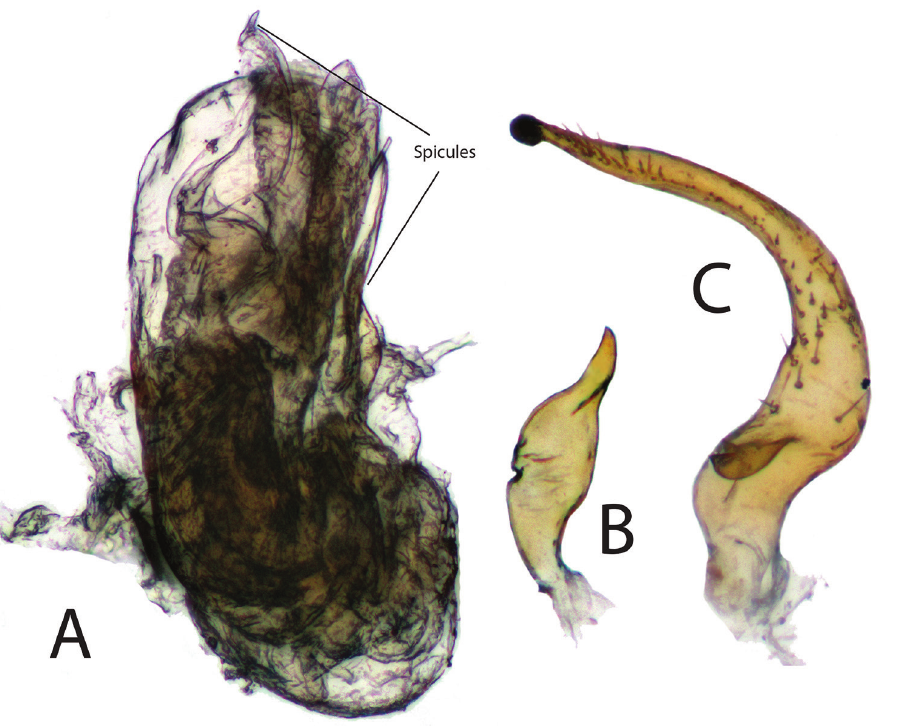
Figure 4. Male genitalia of Philicoris mayon sp. n. showing A endosoma B right paramere, and C left paramere. Images taken at 100× using a compound light